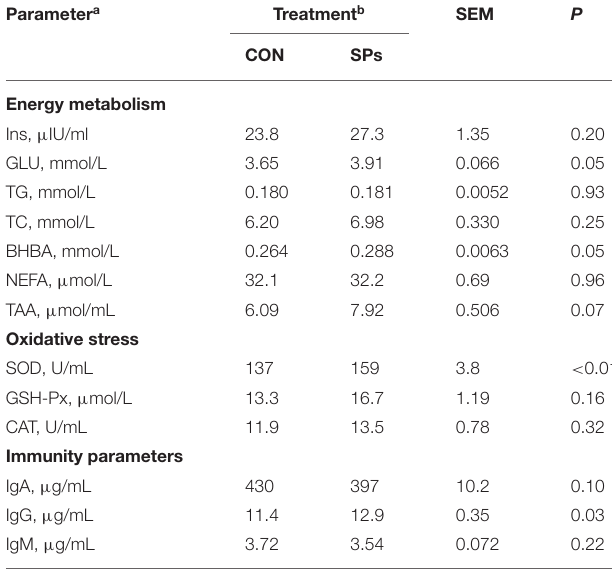
TABLE 7 | Effects of the dietary supplementation of soybean peptides (SPs) on the blood parameters of lactating dairy cows on the last day of the experiment. Parameter a Treatment